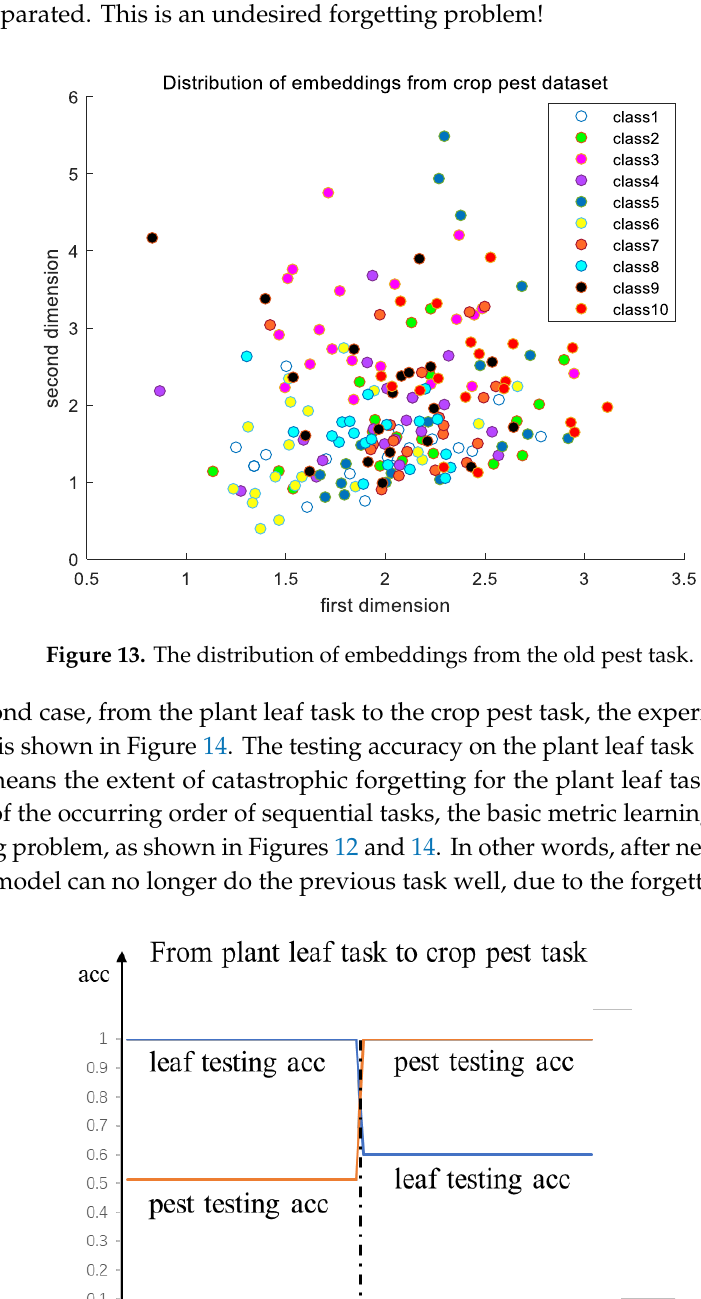
Figure 14. The testing accuracy of the second case. The distribution of embeddings from the old plant leaf task is shown in Figure 15, which is very mixed and chaotic, losing the ability to distinguish and classify the similarity between input paired images. Figure 15. The distribution of embeddings from the old leaf task. 3.3. Continual Tasks Experiment with Our Proposed Method As known, due to the forgetting problem, the basic CNN model cannot balance new and old tasks. Taking tthe sequential tasks from the crop pest dataset to the plant leaf dataset as an example,